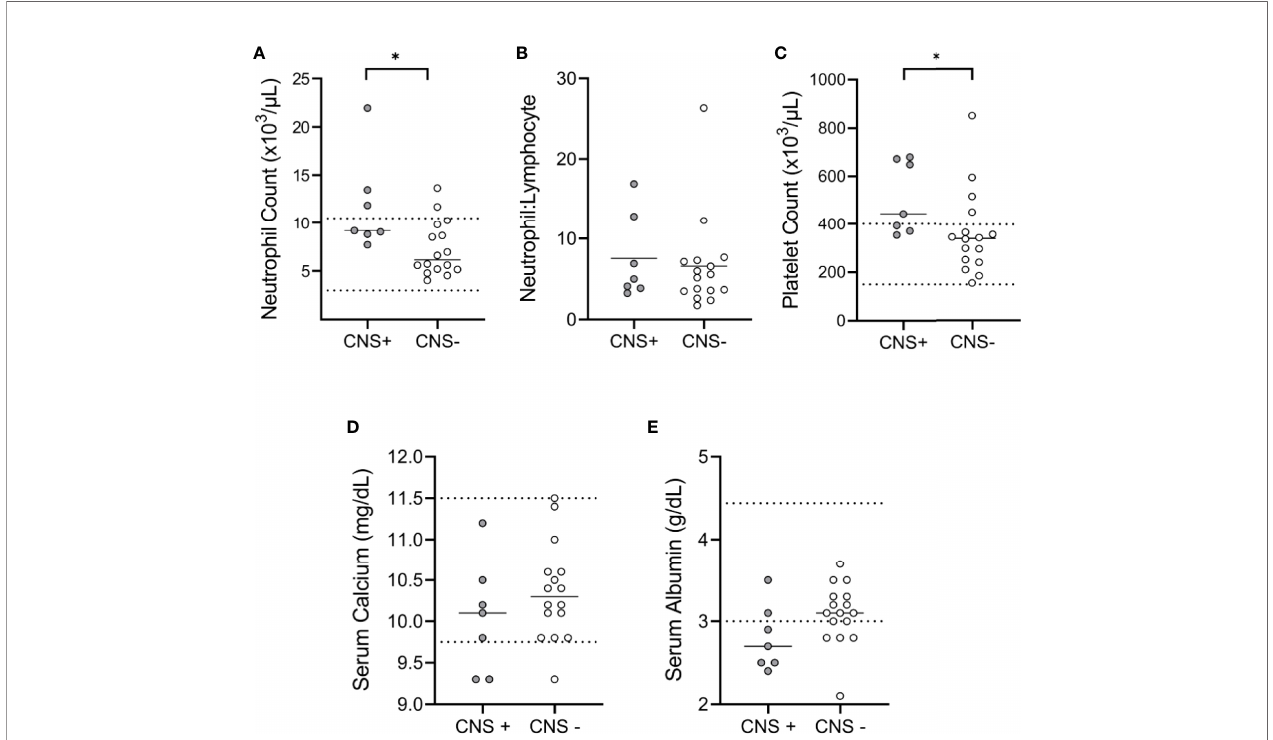
FIGURE 2 | Clinicopathologic features of canine malignant melanoma. CBC and chemistry panel data were available for comparison between CNS+ (n=7) and CNS- (n=16) dogs. (A) The median neutrophil count was higher in CNS+ dogs (p= 0.015). (B) Neutrophil to lymphocyte ratios were not different between groups (p= 0.579). (C) The median platelet count for CNS+ dogs was higher than CNS- dogs (p= 0.018). No differences were observed in (D) serum calcium (p=0.299) or (E) albumin (p=0.077) between groups. Dashed lines represent hospital normal reference ranges. Comparisonsbased onWilcoxon-Mann-Whitney ranksum test.